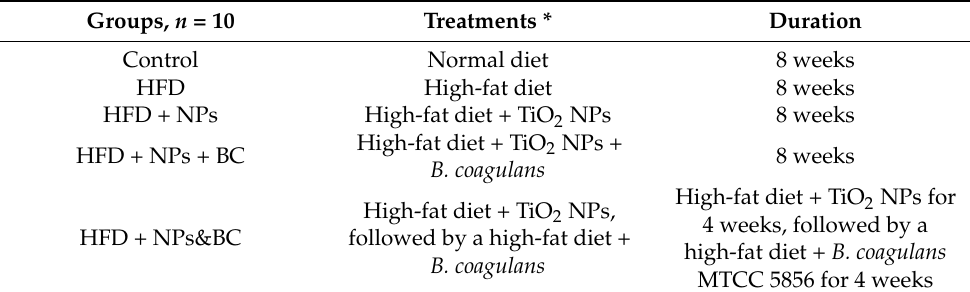
Table 1. Animal groups and treatments. Groups, n = 10 Treatments * Duration